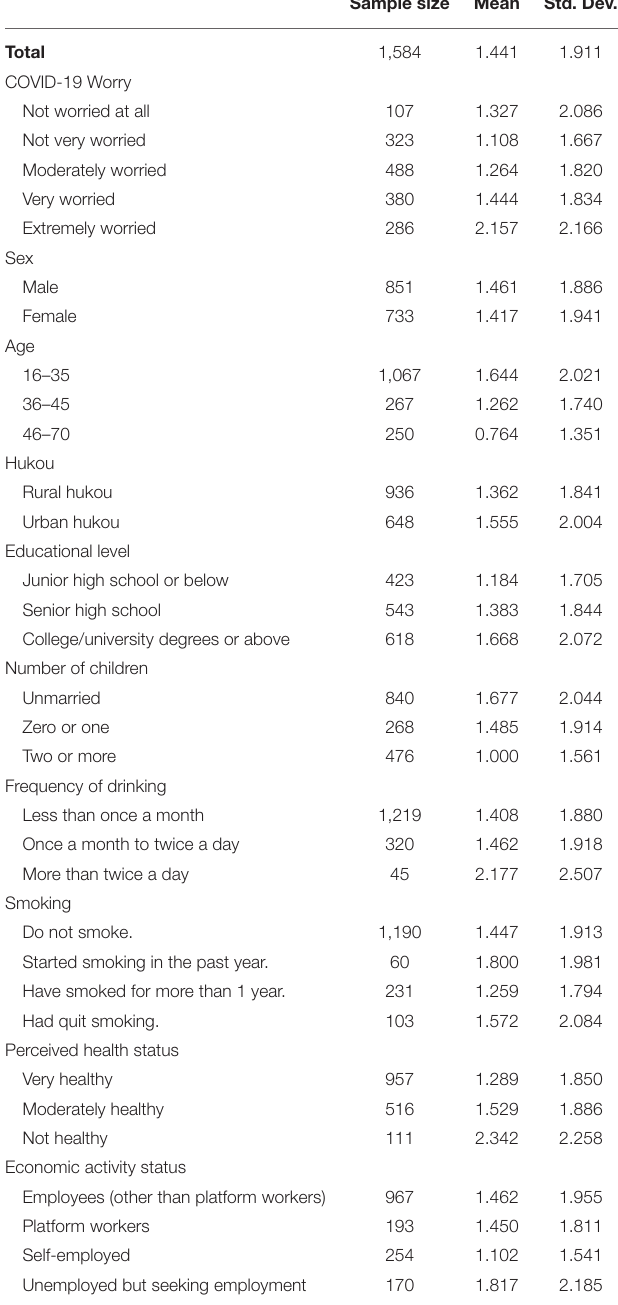
Sample size Mean Std.